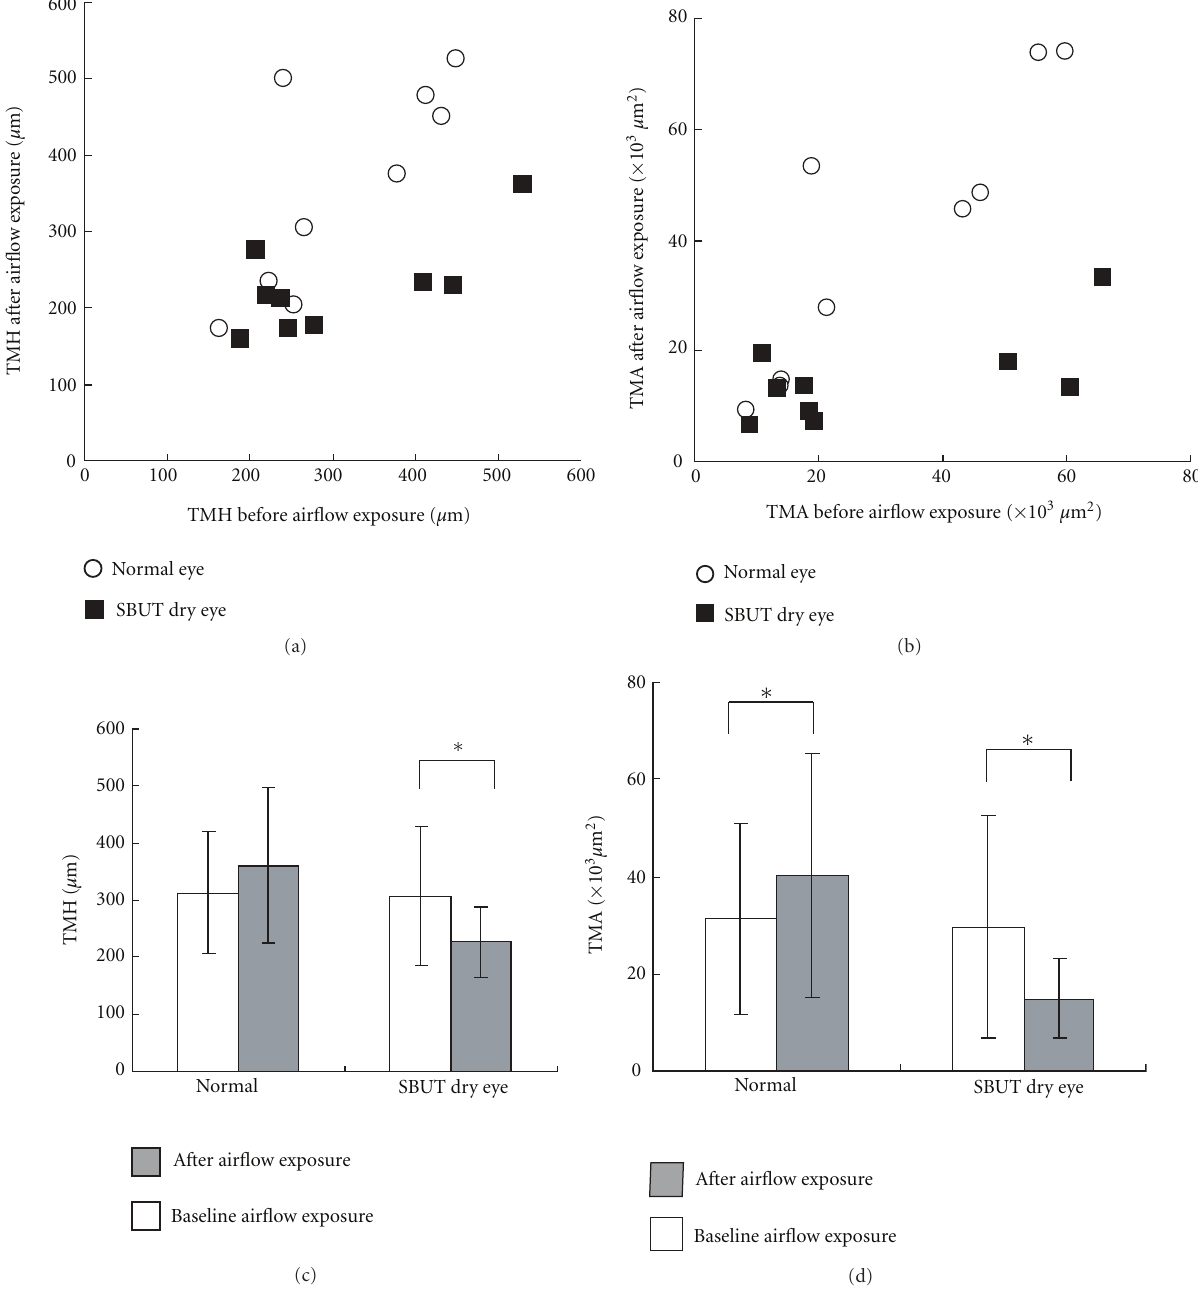
Figure 2: (a)-(b) Airflow-exposure-induced changes in the tear meniscus are presented for normal and short tear film breakup time dry eye (SBUT dry eye) groups. (c)-(d) In SBUT dry eye, both TMH and TMA decreased significantly ( P = 0 . 027 and P = 0 . 027, resp., Wilcoxon signed-rank test). SBUT dry eye: short tear film breakup time dry eye; TMH: tear meniscus height; TMA: tear meniscus